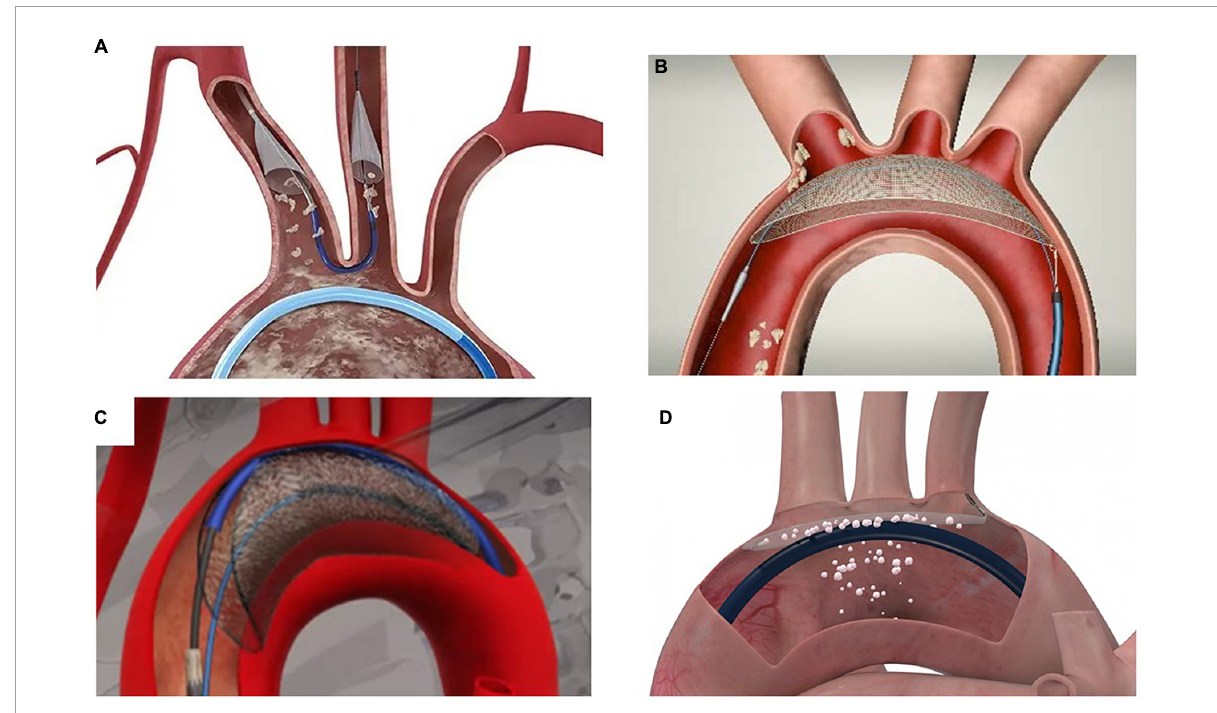
FIGURE2 Cerebral embolic protection devices with published data. (A) Sentinel R (cid:13) Cerebral Protection System (Boston Scientific, Marlborough, Massachusetts). (B) TriGUARD 3 Cerebral Protection Device (Keystone Heart, Tampa, FL, USA, a Venus Medtech Company). (C) Emblok Embolic Protection System (Innovative Cardiovascular Solutions, Grand Rapids, Michigan). (D) ProtEmbo R (cid:13) Cerebral Protection System (Protembis GmbH, Aachen,